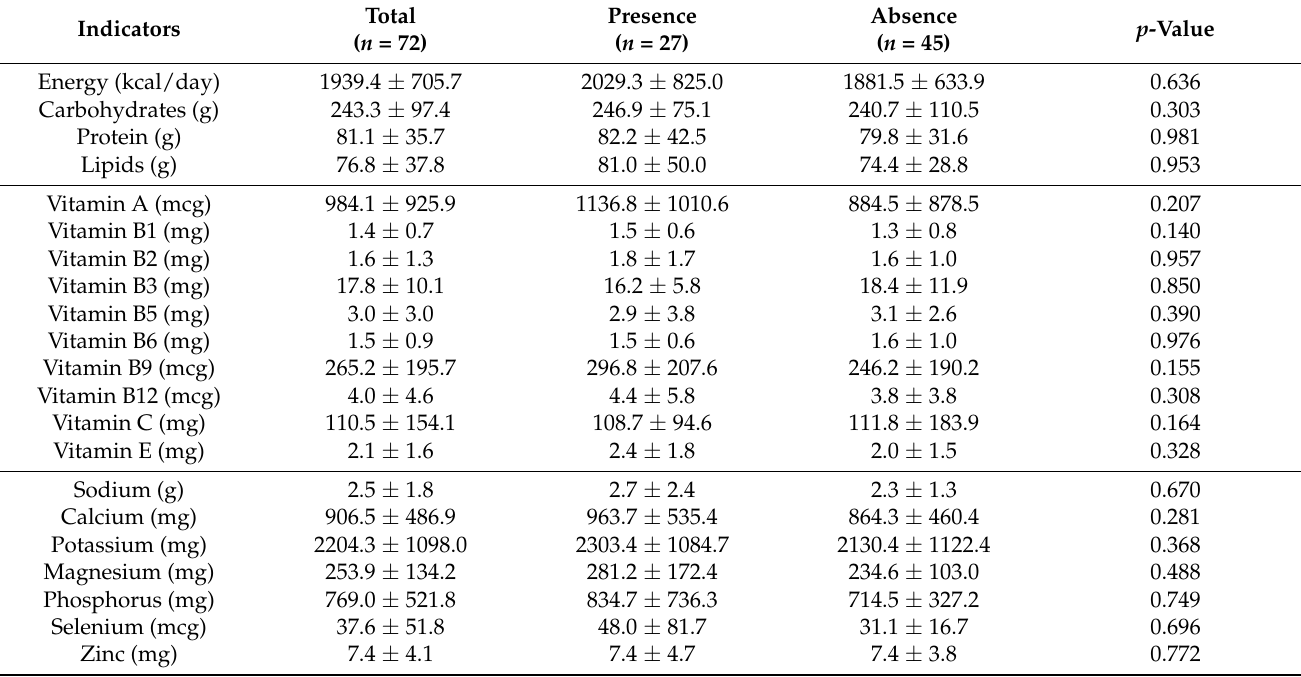
Table A3. Dietary characteristics regarding insulin resistance.